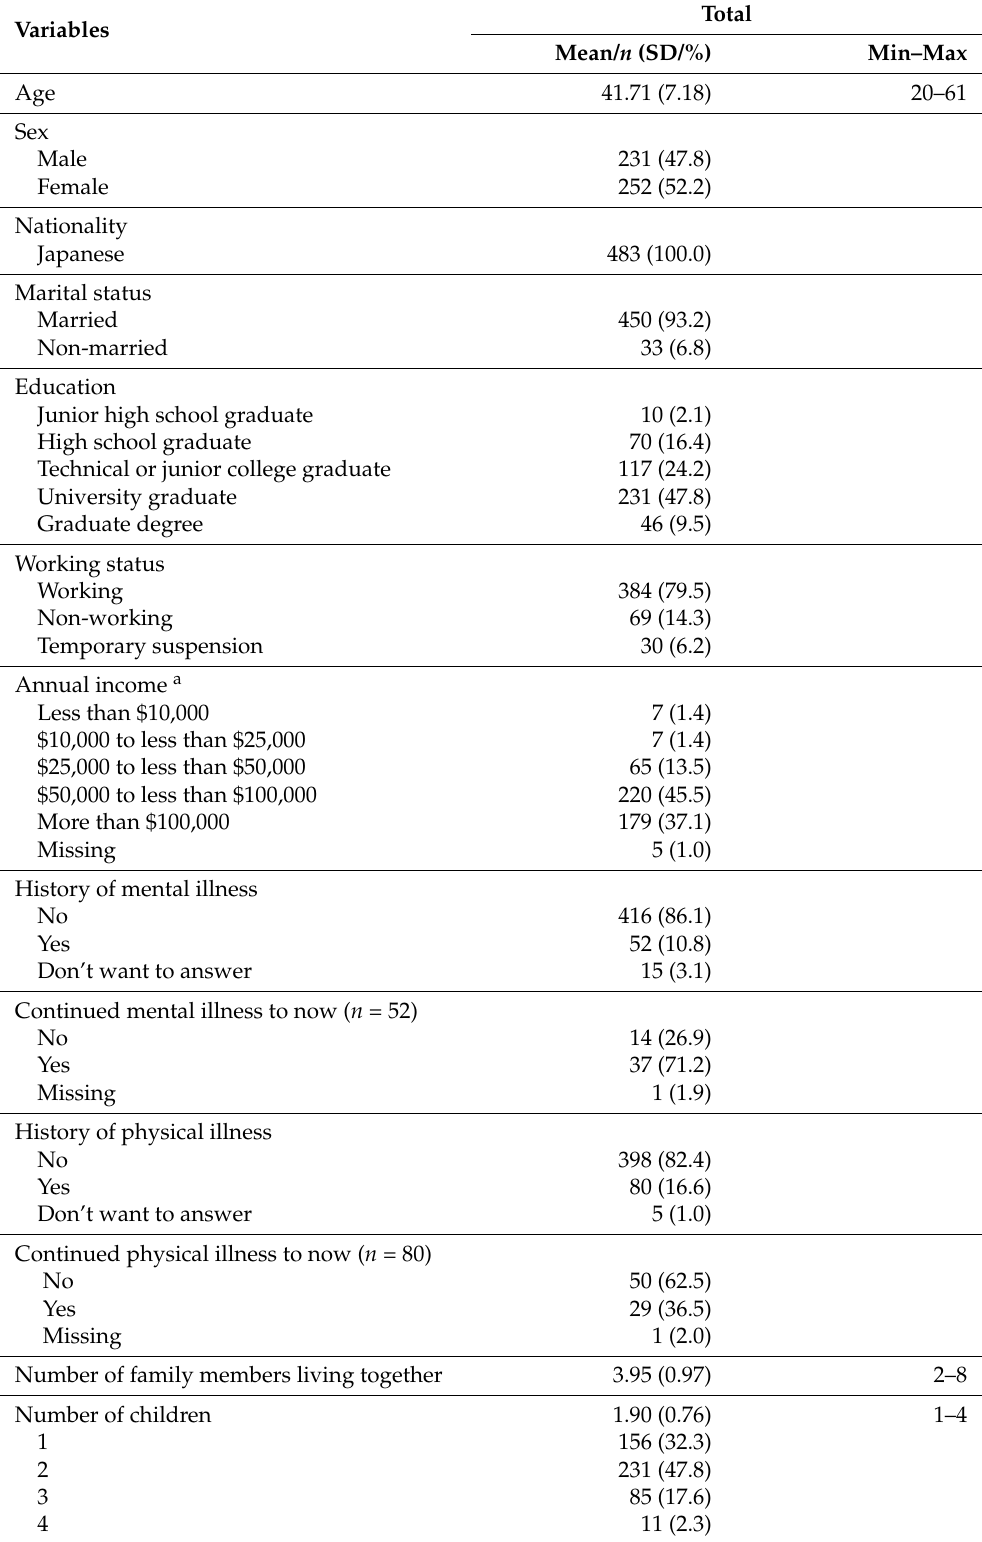
Table 1. Descriptions of Demographics ( n =